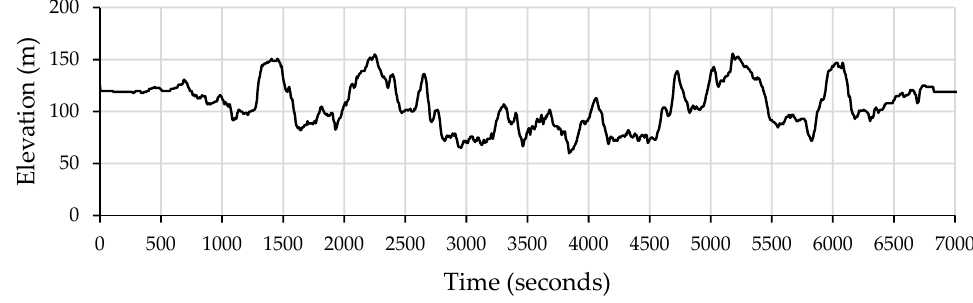
Figure 9. Elevation of the extra-urban route (m).